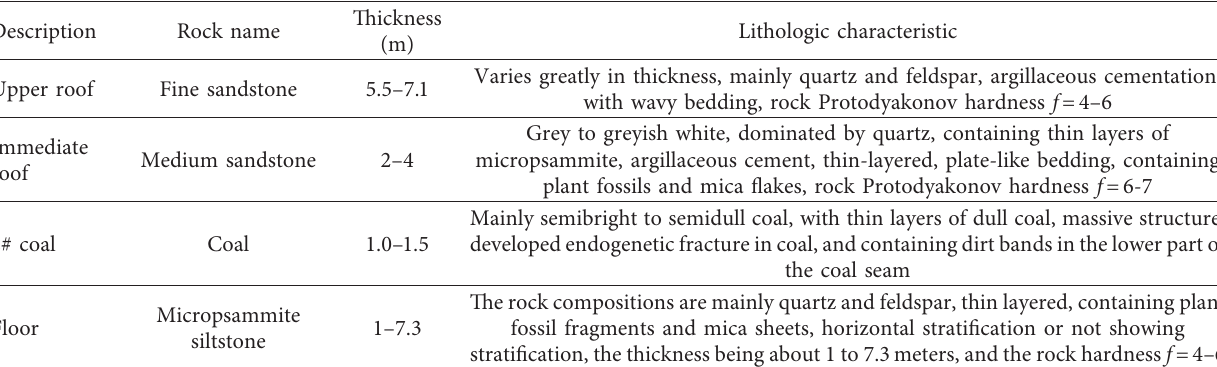
Table 1: Characteristics of adjoining rock on roof and floor of No. 21209 working